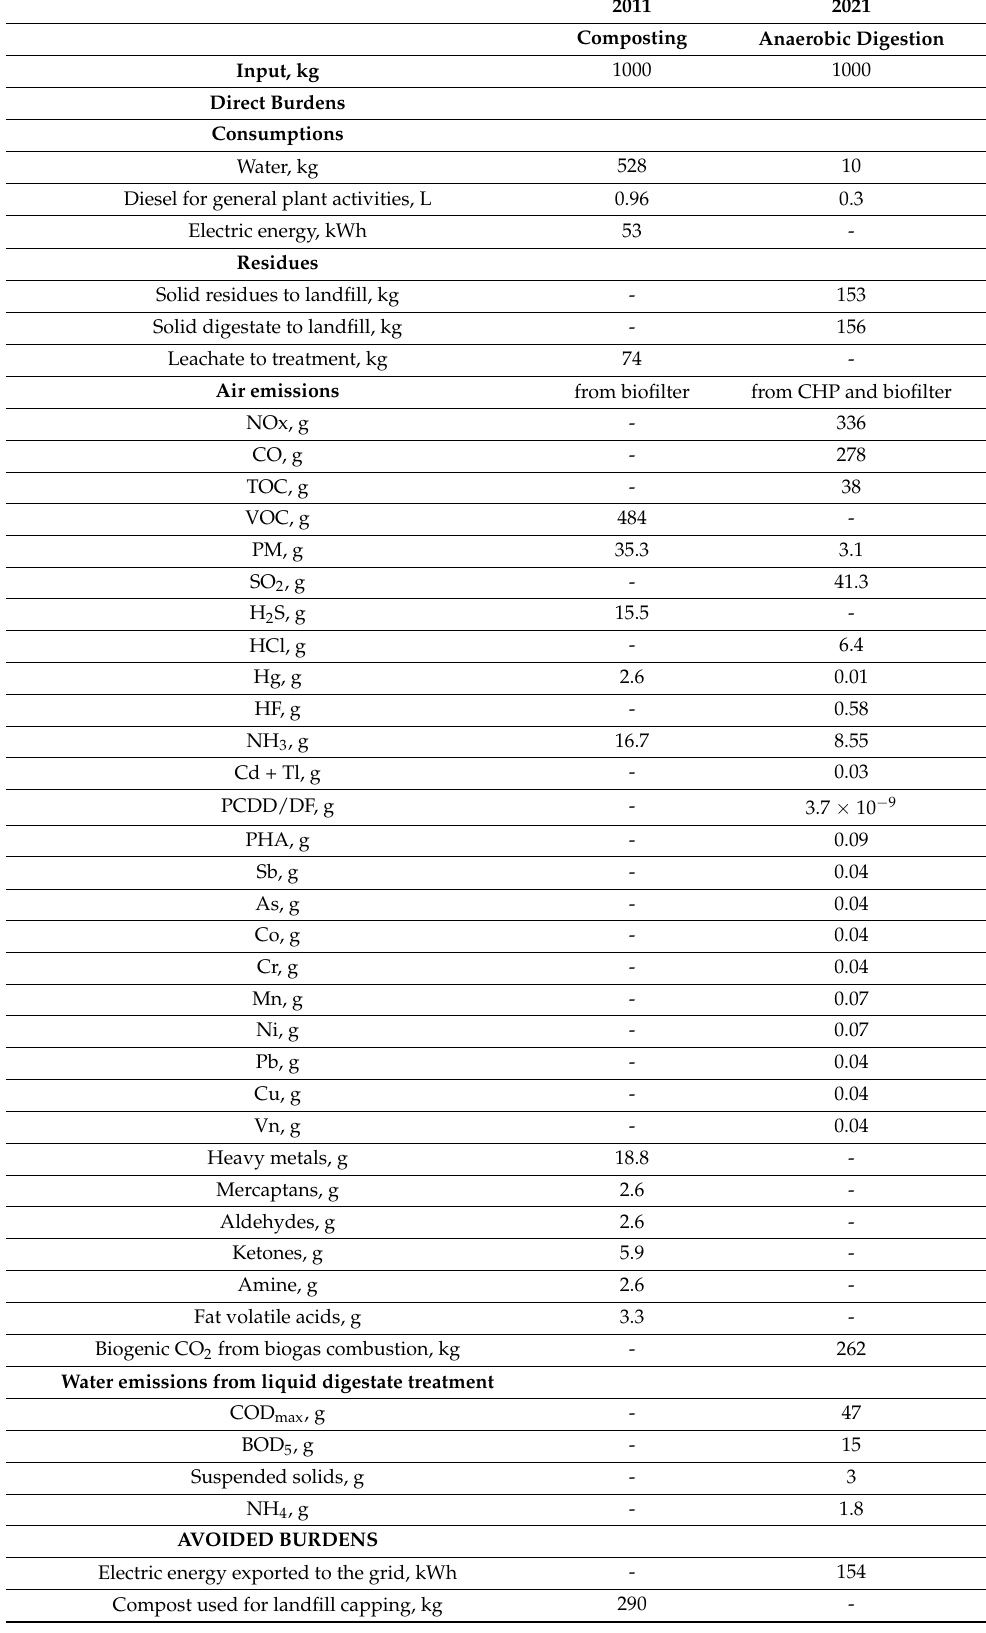
Table 3. Direct and avoided burdens related to management of separately collected biowaste (EWC 200108 and 200201). Data Source: